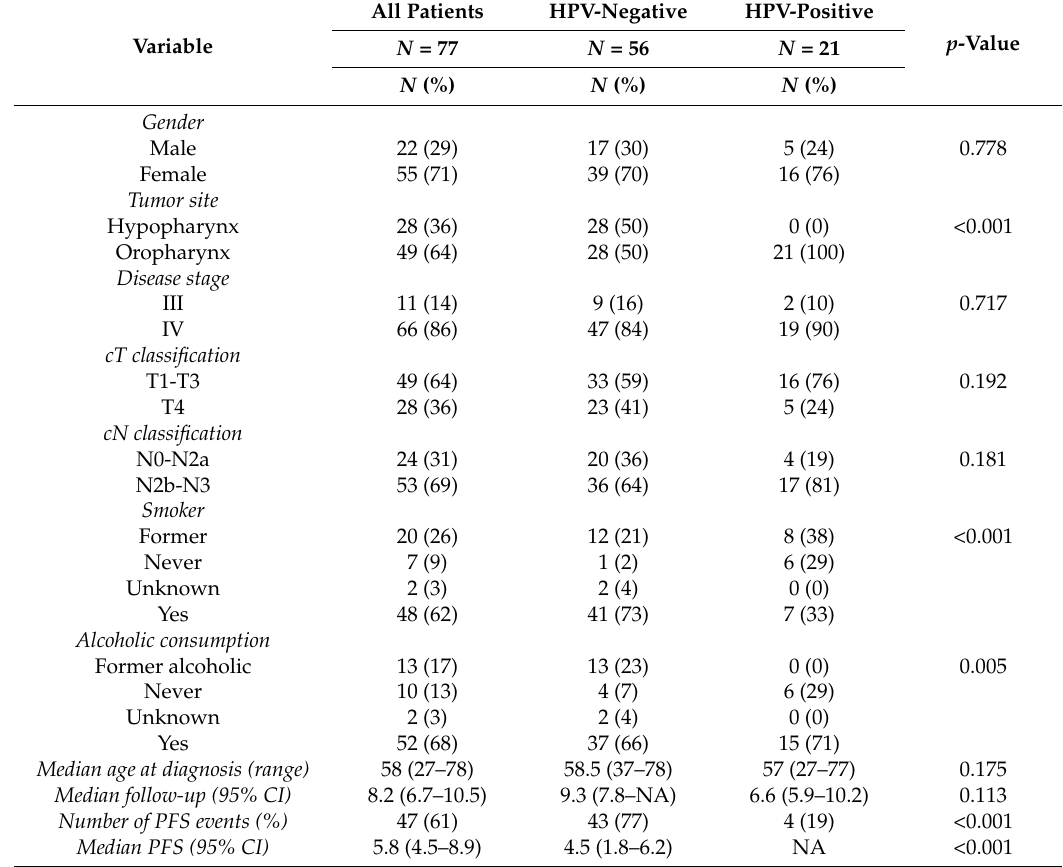
Table 1. Patient and tumor characteristics. Follow-up and progression free survival (PFS) times in years.